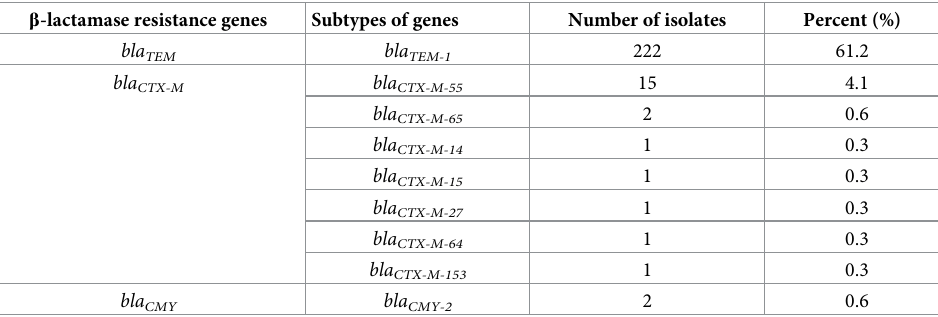
Table 4. The prevalence of β -lactamase resistance genes of Salmonella